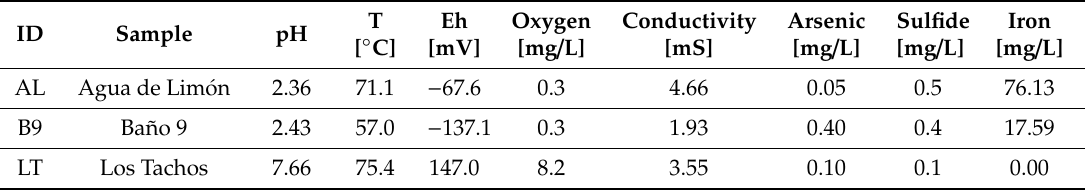
Table 1. Physicochemical parameters measured in